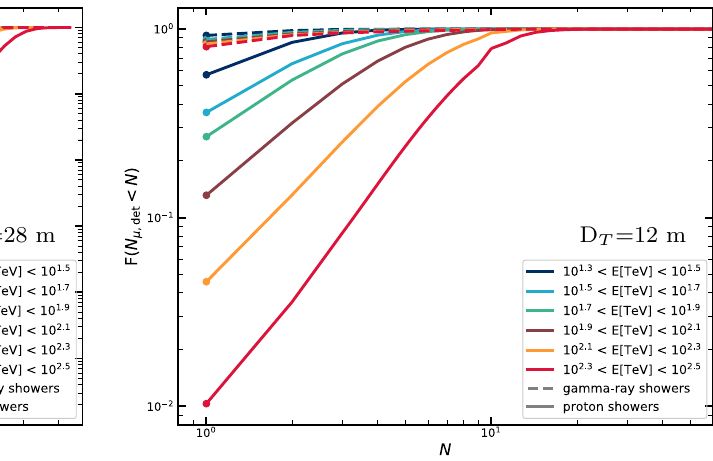
placed at the x-position defined by a 70% signal efficiency. The corre- sponding telescope size is indicated with D T in each